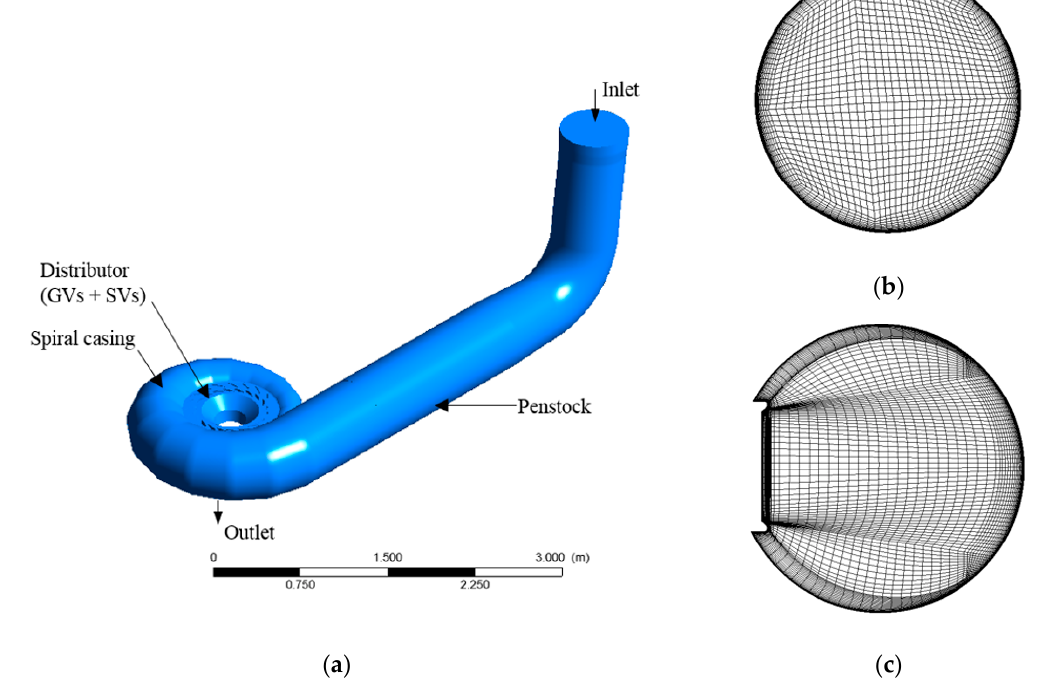
Figure 3. ( a ) Computational domain; ( b ) mesh at a section of the penstock; ( c ) mesh at a section of the SC.